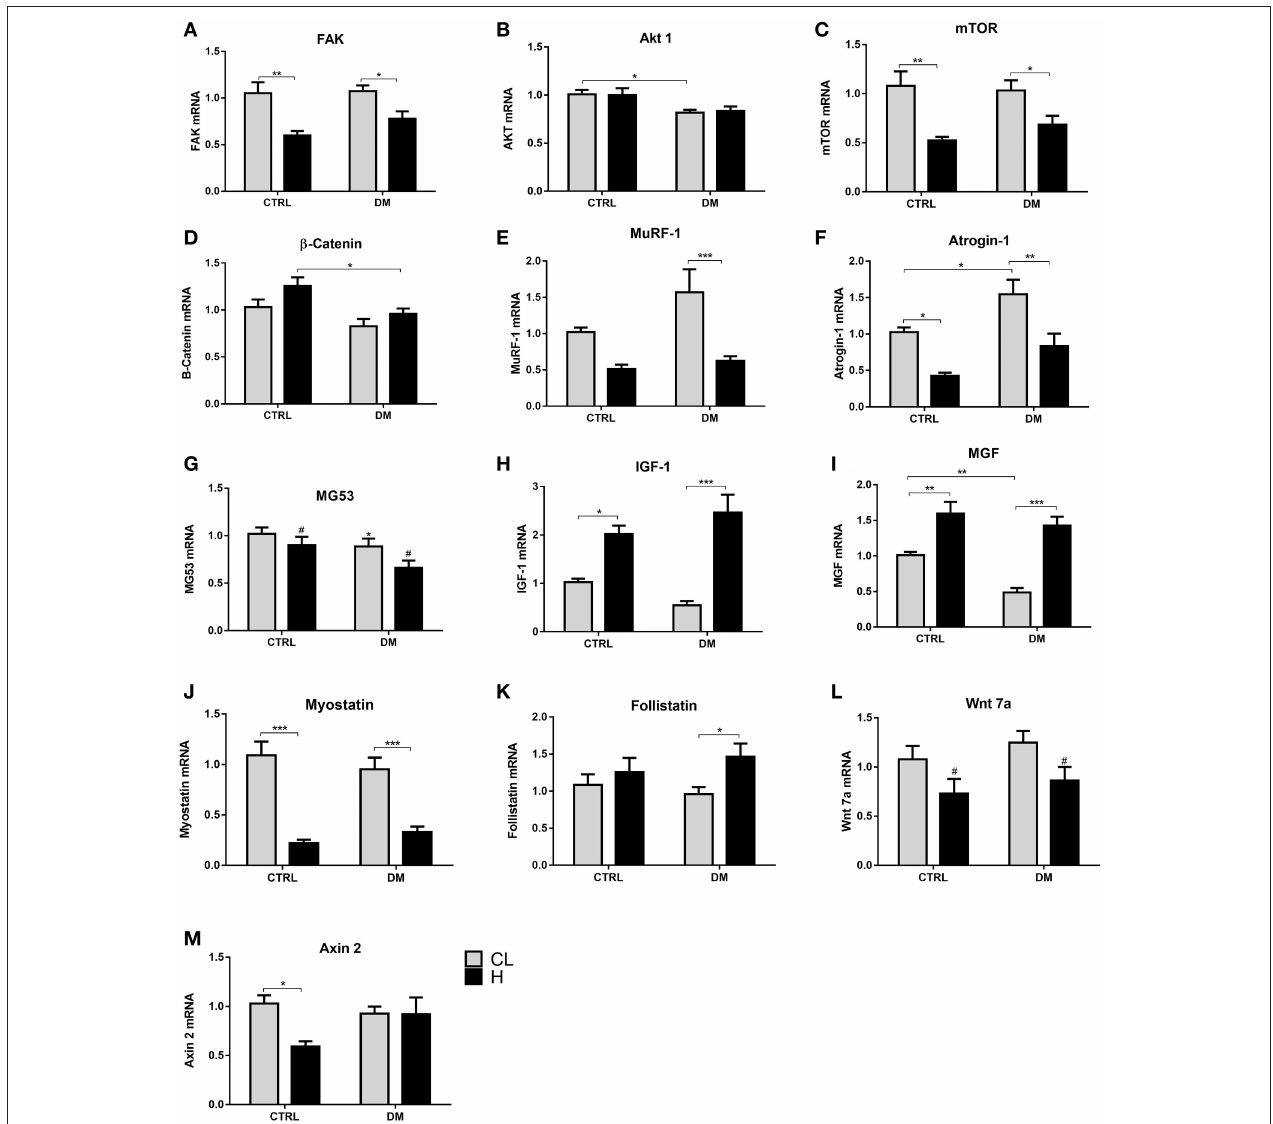
FIGURE 7 | (A–F, H–K, M) mRNA expression of several genes in the soleus muscle after 7 days of overload. Results are presented as mean ± SEM of at least nine animals. Data were analyzed using two-way ANOVA followed by Bonferroni post-test. * p < 0.05, ** p < 0.01, *** p < 0.001. In (G) , * p < 0.05 CTRL vs. DM and # p < 0.05 for CTRL-CL/DM-CL vs. CTRL-H/DM-H, in (L) , # p < 0.05 for CTRL-CL/DM-CL vs. CTRL-H/DM-H using two-way ANOVA only. CL, Contralateral muscle; H, Hypertrophied muscle; DM, Diabetic group; CTRL, Control